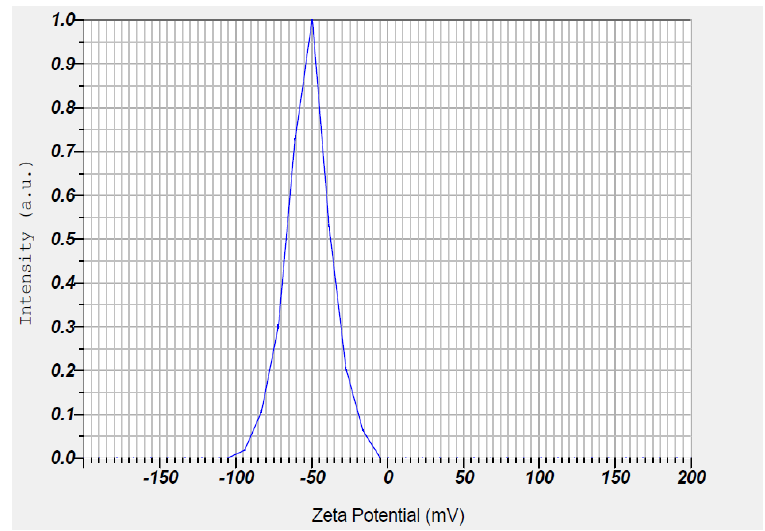
Figure 6. Zeta potential analysis of ZnO NPs.